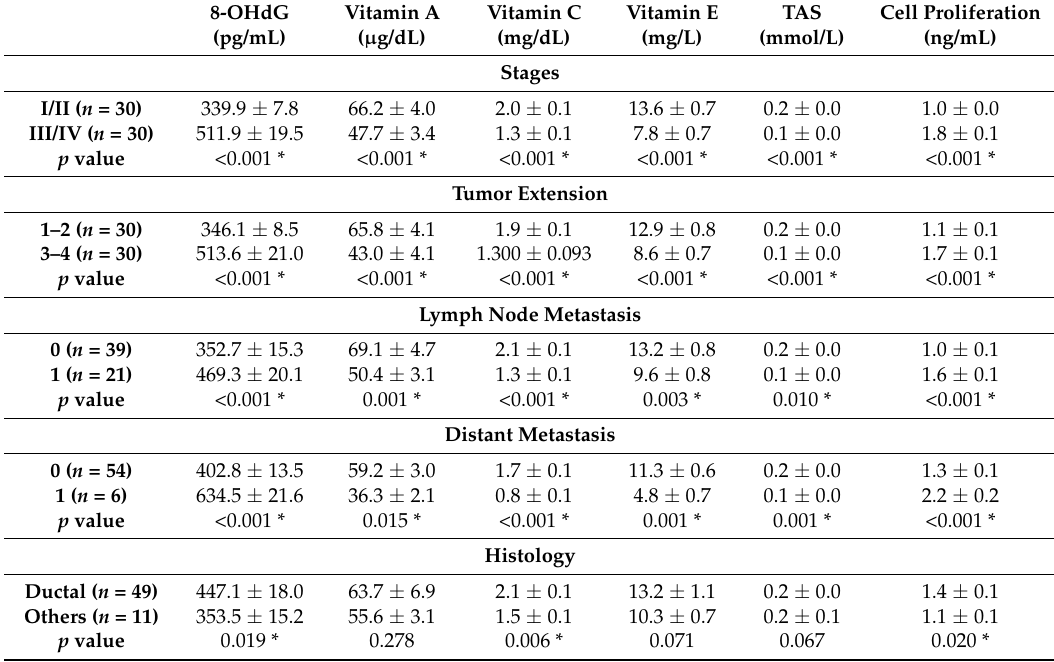
Table 4. Levels of non-enzymatic antioxidant in patients with breast carcinoma in relation to their clinico-pathological